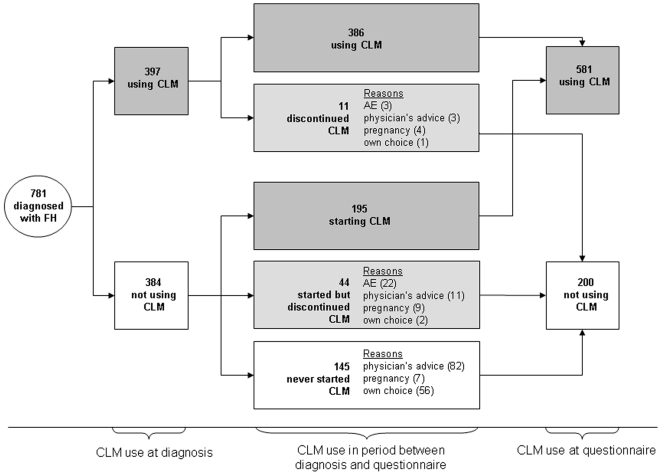
Use of cholesterol-lowering medication between molecular diagnosis of FH and completion of questionnaire.Molecular diagnosis of FH was made in 2006 and the questionnaire was send and completed in 2008. AE = adverse events related to CLM; FH = familial hypercholesterolemia; CLM = cholesterol-lowering medication; pregnancy = no use of medication due to pregnancy, intention to become pregnant or breastfeeding.